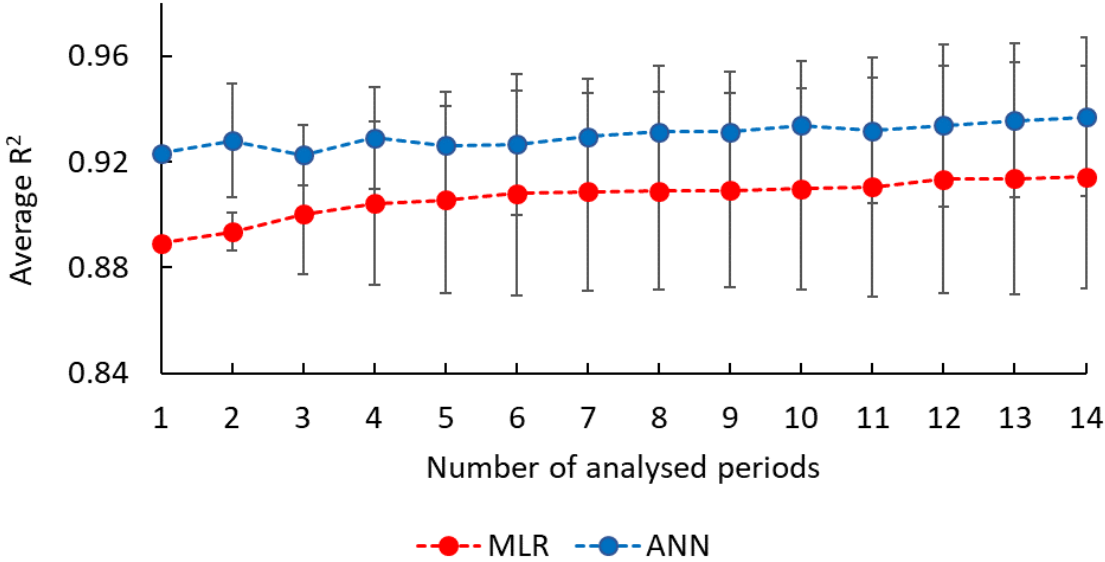
Figure 7. Average values of R 2 for model validation based on sub-periods of variable durations, from 141 days (one period) to 10 days (14 periods). The horizontal axis depicts the number of sub-periods in each analysis, and the Y-axis shows the average R 2 for equal-duration sub-periods. Vertical bars indicate the standard deviation of the mean. MLR — red; ANN — blue.